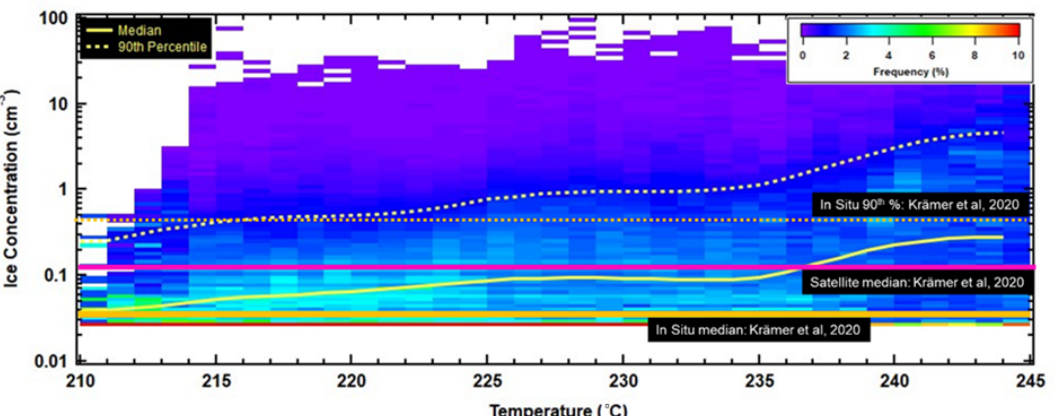
Figure 3. Frequency distribution of cloud ice concentration versus temperatures for all measured ice clouds. The measurements are presented in a format similar to Fig. 7b in Krämer et al. (2020), with the in situ median, satellite-derived median and 90th percentiles shown by the horizontal orange, magenta and dashed orange lines, respectively. The median and 90th percentile values for the data set reported here are shown with the solid and dashed yellow curves,